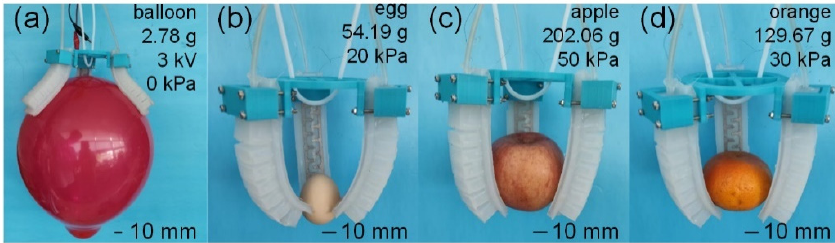
Figure 12. Demonstration of gripping capability. ( a ) shows the EA gripping capability; ( b – d ) shows the pneumatic grasping